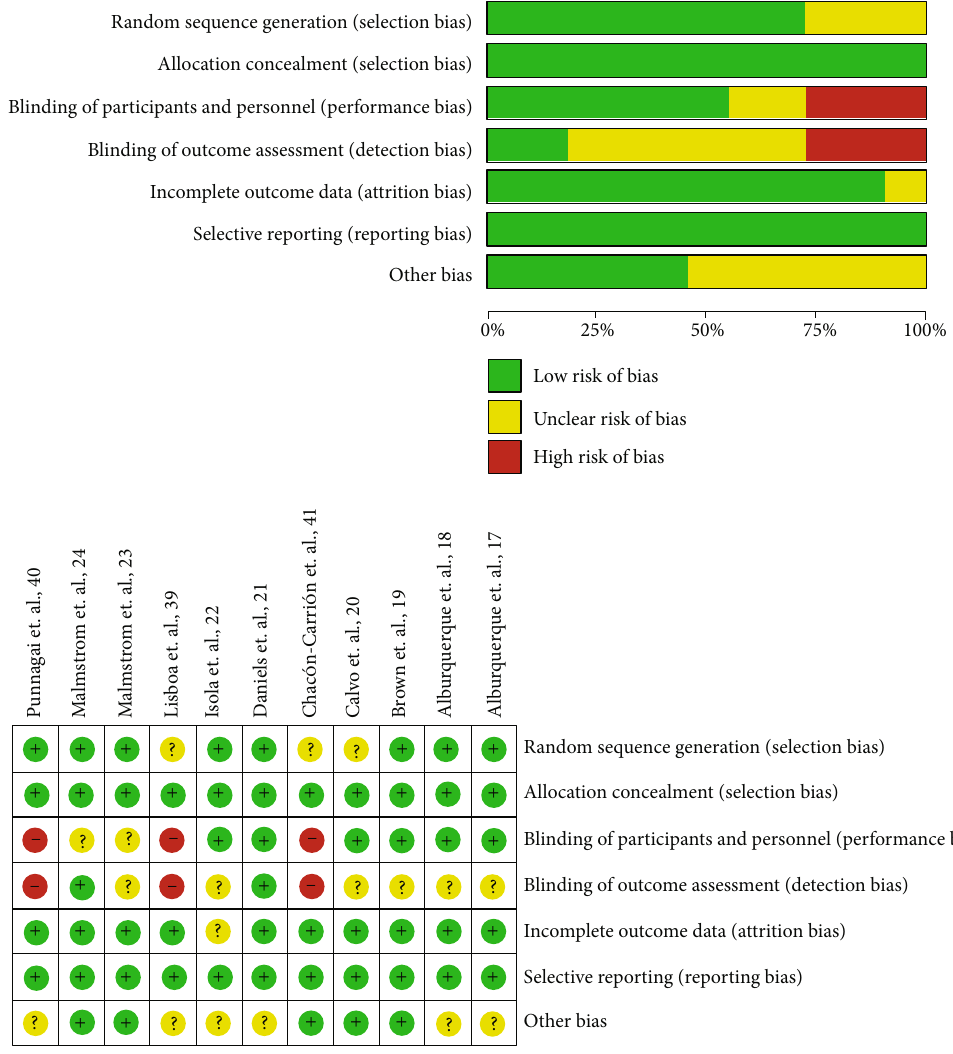
Figure 2: Risk of bias assessment of full text